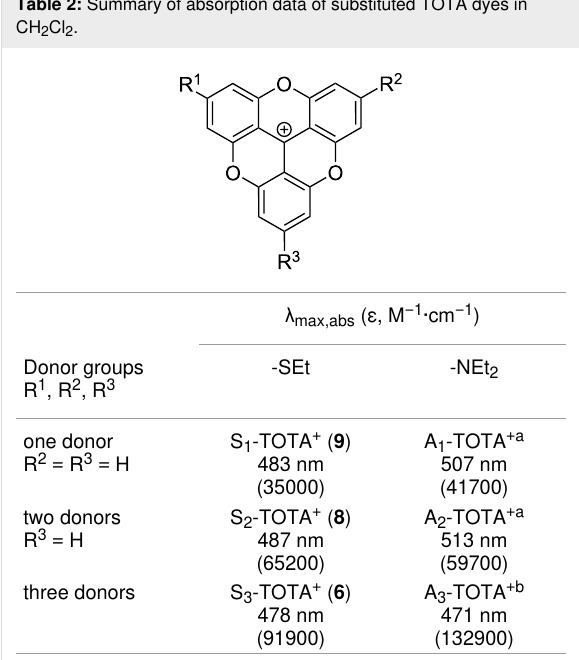
When three -SEt groups are placed on the asymmetric azadioxa- triangulenium core, as in S 3 -ADOTA + ( 5a ), the presence of two